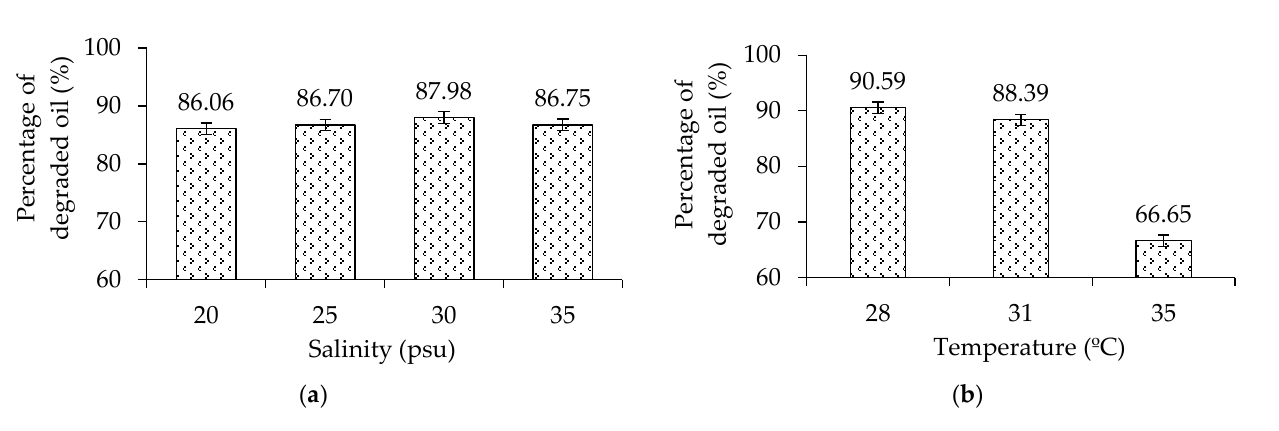
Figure 8. Percentage of degraded oil on ( a ) salinity variation at controlled temperature 28 °C and ( b ) temperature variation after 3 days of incubation. At 35 °C, the oil degradation process by bacteria was ineffective.